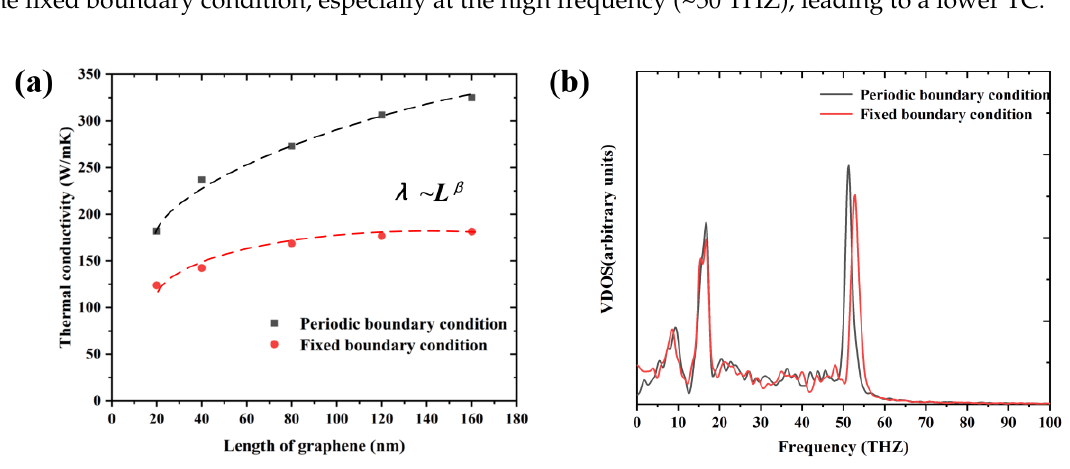
Figure 11. ( a ) The variation of TCs of pristine Gr with respect to length; and ( b ) the VDOS of Gr under periodic/fixed boundary conditions.